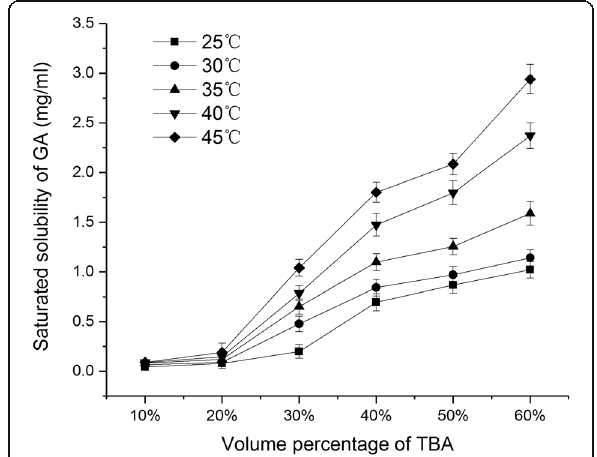
Fig. 1 Saturated solubility of GA in TBA/water co-solvent with different volume percentage (mean ± SD, n =